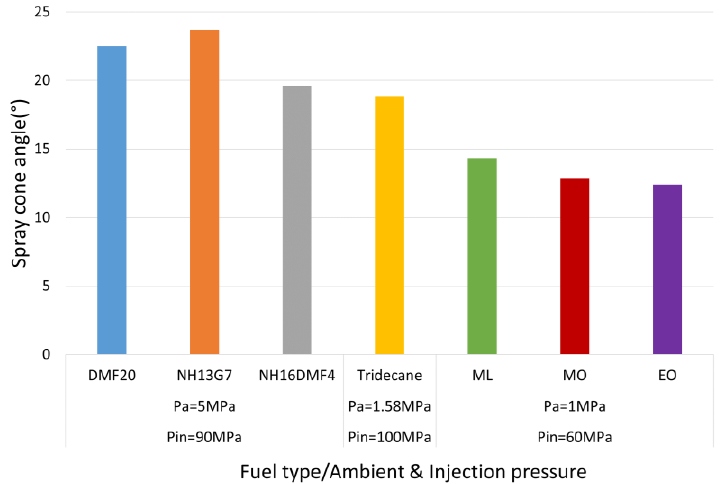
Figure 15. Spray cone angle for esters, aliphatic and aromatic additives with diesel at different injection & ambient pressures [99,106,108].